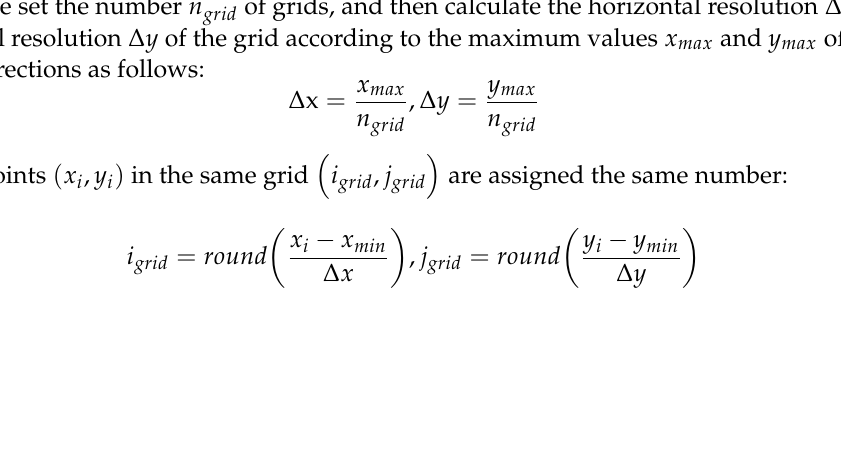
Figure 4. The grid threshold method. The original data are projected two-dimensionally and meshed. Part of the ground data consists of these points whose quantity is one in the grid.